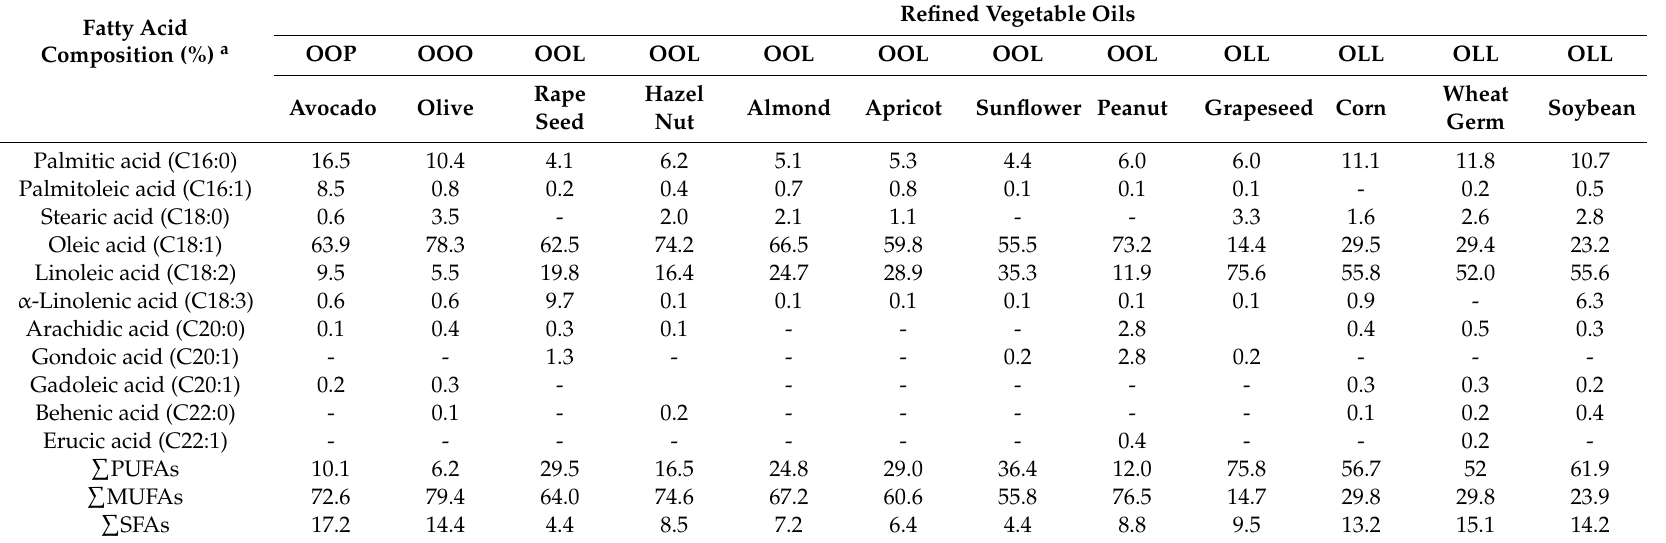
Table 1. Composition of fatty acids in vegetable oils identified by fatty acid methyl ester (FAME)